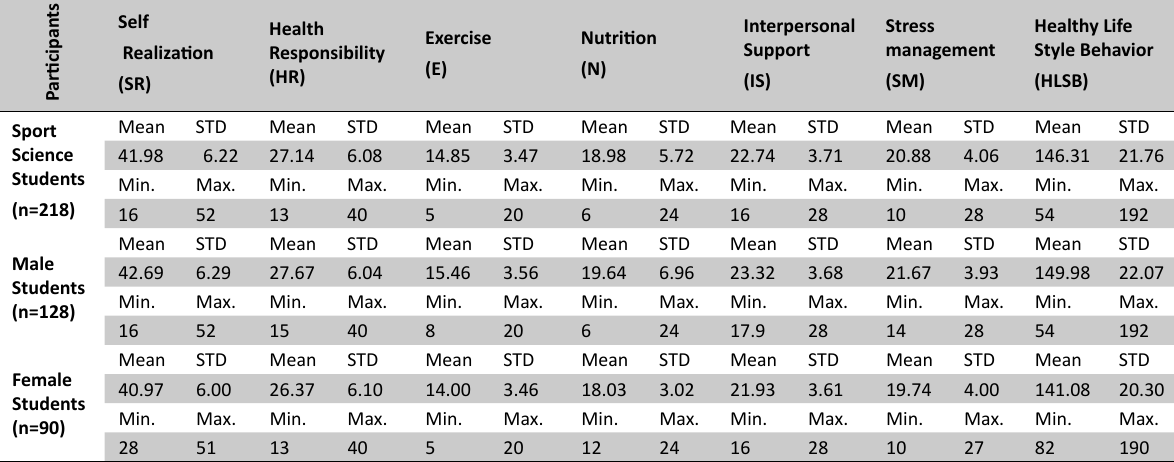
Table 3. Average, standard deviation and range variability values of the healthy life style behavior of the sport science students